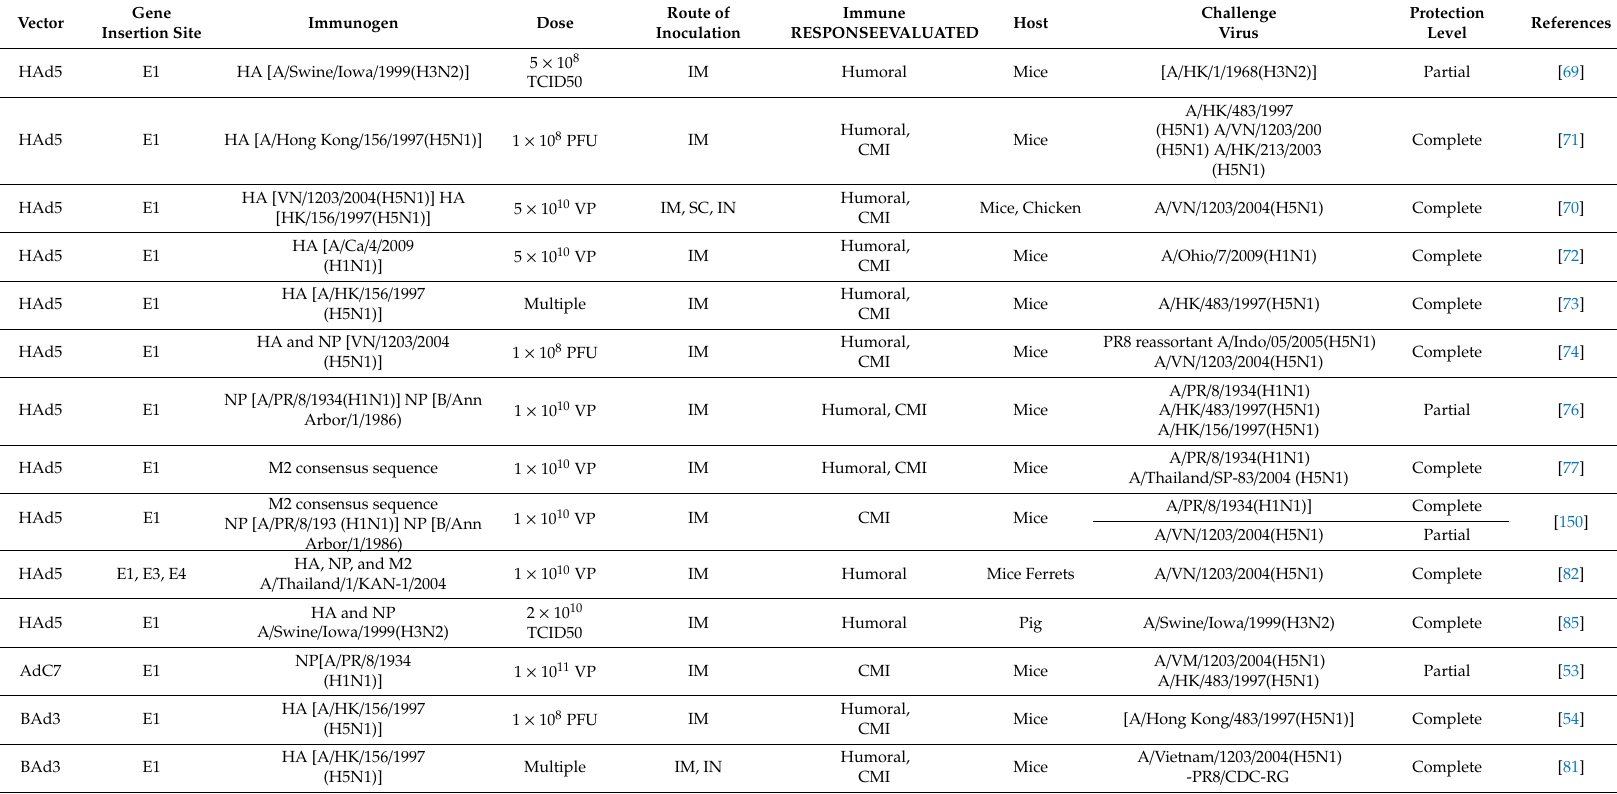
Table 1. Preclinical trials with adenoviral vector-based influenza